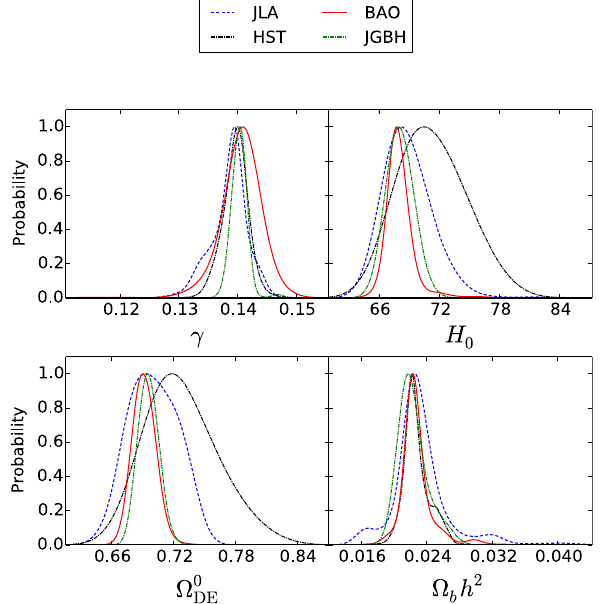
Fig. 13 Marginalized posterior function for various free parameters of the dynamical dark energy model. The dashed line represents observa- tional constraint by joint analysis JLA + GRBs. The solid line corre- sponds to BAO analysis while long-dashed line indicates observational consistency for HST project